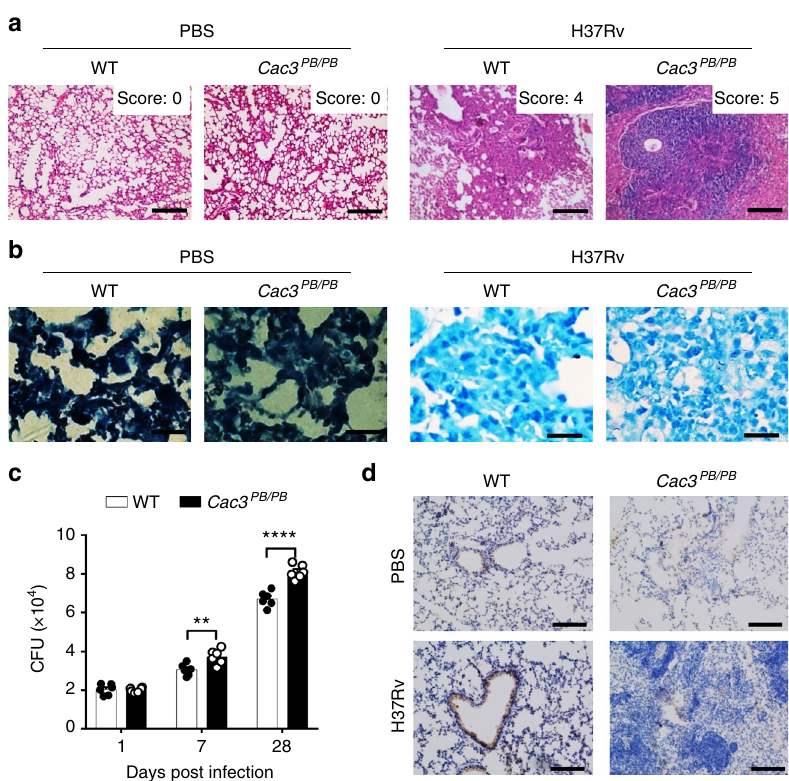
Fig. 5 Cacna2d3 -mutant mice are more susceptible to Mtb infection. FVB and Cac3 PB/PB mice were infected with Mtb or treated with PBS for 28 days, and the lungs were subjected to ( a ) H&E staining. Scale bar, 100 μ m. b Acid-fast staining of bacteria. Scale bar, 20 μ m. c CFU assay. d Immunohistochemistry of LC3B. Brown signal indicated LC3. Scale bar, 100 μ m. **p < 0.01, ****p < 0.0001 by the Mann – Whitney U test ( c ). Data are representatives of three independent experiments. In c , data are representatives of three independent experiments with biological duplicates in each ( c mean ± s.e.m. of n = 6